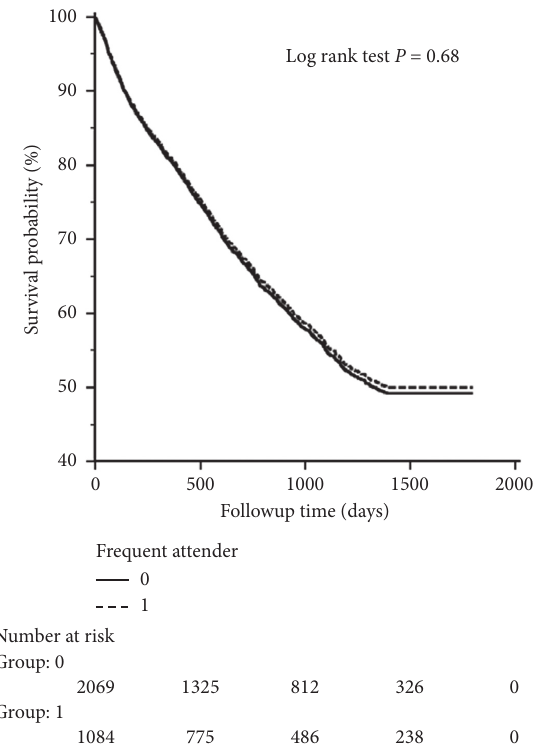
Figure 1: Kaplan–Meier (KM) curve for study-period